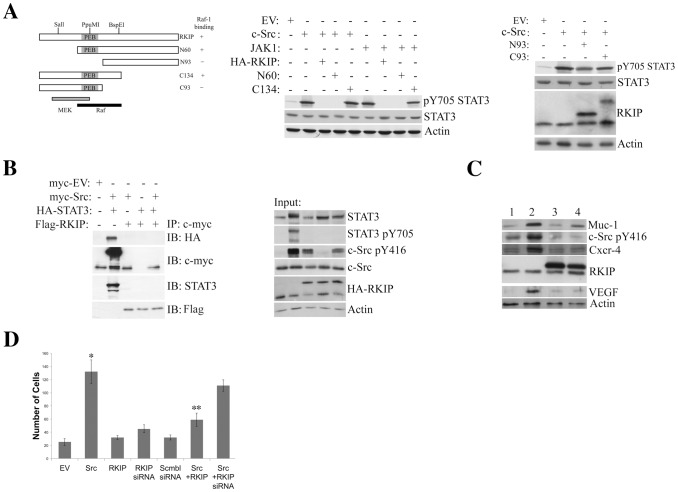
RKIP inhibits Src-STAT3 interaction.(A), top panel, Cartoon depicting a series of RKIP deletion constructs that were examined for their ability to inhibit c-Src- and JAK1-mediated STAT3 activation. Middle panel, Some of the deletion constructs were transfected in the presence of c-Src or JAK1 into cells for 48 h. Whole cell protein lysates were examined for the expression of STAT3, STAT3 pY705 and actin. Lower panel, Cells were transfected with EV, c-Src or RKIP deletion constructs N93 and C93. After 48 h, cells were harvested and whole cell lysates prepared to examine the expression of the indicated proteins via Western blot analysis. (B) Cells were transfected with c-myc EV, or the following tagged expression plasmids: myc-c-Src (2 μg), HA-STAT3 (2 μg), Flag-RKIP (4 μg) or the combination for 48 h. Cells were lysed in RIPA buffer, cellular debris removed, a portion of the sample removed as the IP input and the remaining supernatant incubated and rotated with an antibody to c-myc for 4 h at 4°C. Subsequently, protein G agarose was added and the samples rotated overnight at 4°C. Protein G agarose containing immuno complexes was extensively washed, 2× sample buffer added and the samples heated at 95°C for 5 min. Proteins were separated by SDS-PAGE, transferred onto nitrocellulose. The samples subjected to IP were divided in half. One filter was examined with an antibody to HA the other with an antibody to c-myc. The HA filter was stripped and examined for STAT3 levels. The input samples were examined for the expression of the indicated proteins. (C) Western blot analysis of cells transfected with EV (lane 1), c-Src (lane 2), HA-RKIP (lane 3) and c-Src + HA-RKIP (lane 4) to examine the expression of the indicated proteins that were separated on 15% SDS-PAGE. (D) RKIP inhibits c-Src-mediated MDA-231 cell migration. MDA-231 cells were transfected with empty vector, c-Src, c-, HA-RKIP, RKIP siRNA, scrambled siRNA or the combination. The cells were allowed to grow to near confluence. Cells were wounded with a pipette and after 24 h the migrated cells were fixed then stained with crystal violet and quantified. A paired t-test was performed indicating *(p<0.0002) an increase in migration in c-Src transfected MDA cells when compared to EV transfected cells and **(P<0.005) inhibition of c-Src-mediated increase in migration when compared to cells transfected with c-Src and RKIP. The data represents two independent experiments performed in triplicate.